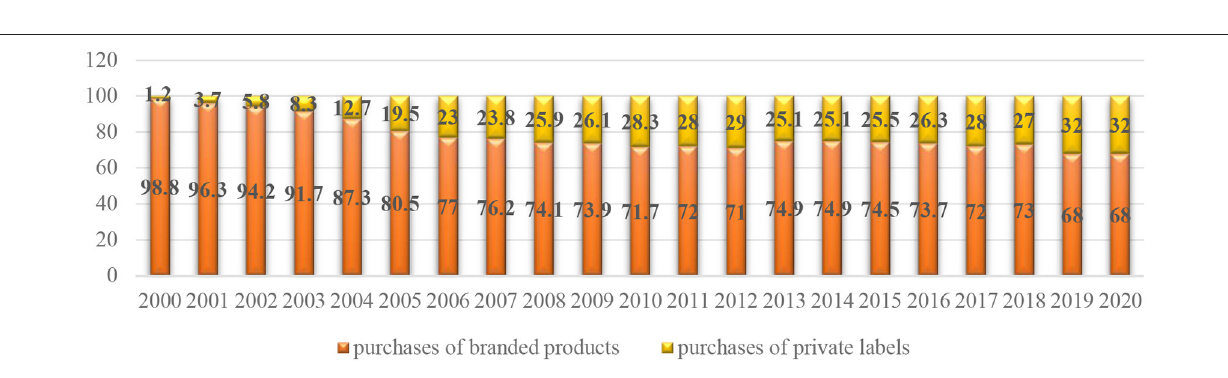
FIGURE 2 | Percentage share of purchases of branded products and products sold under private labels in Slovakia. Source: own processing according to available